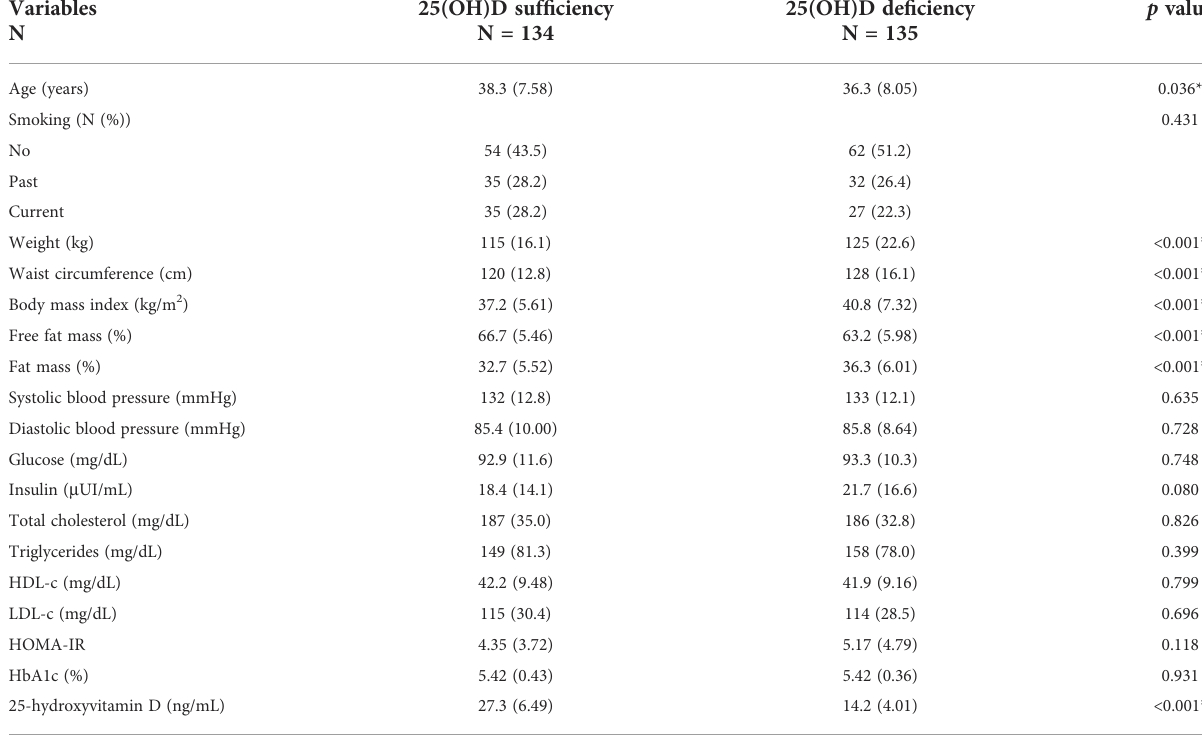
TABLE 1 Summary descriptive table of population study, divided by the 50 th percentile of serum 25-hydroxyvitamin